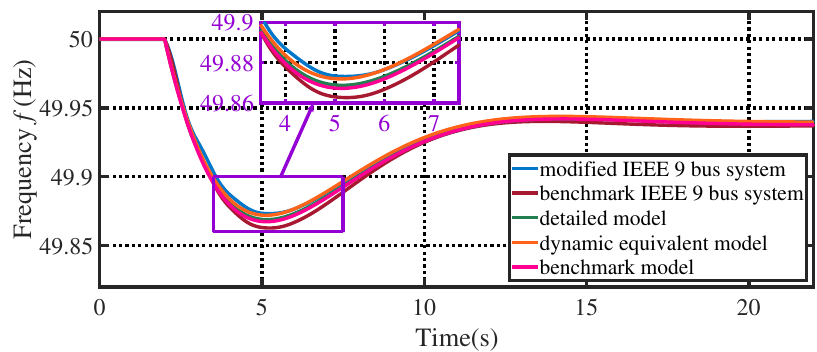
Figure 9. Grid frequency dynamics of different